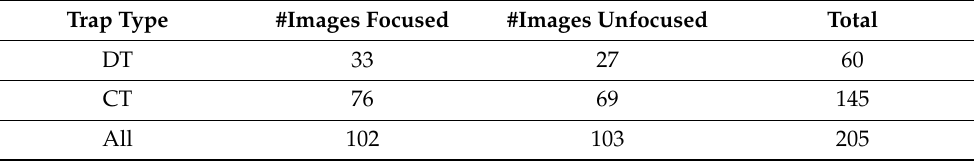
Table 2. Dataset image distribution regarding labelled data for the image focus assessment